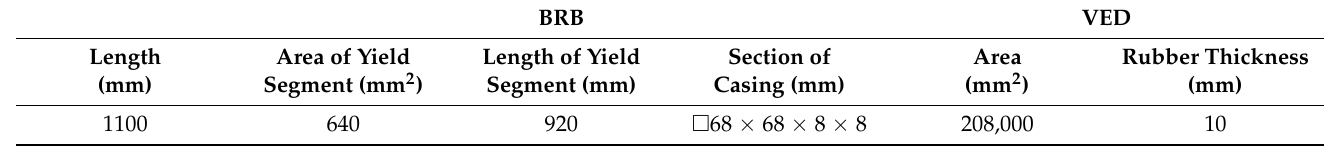
Table 2. Geometric parameters of VBRB specimens.